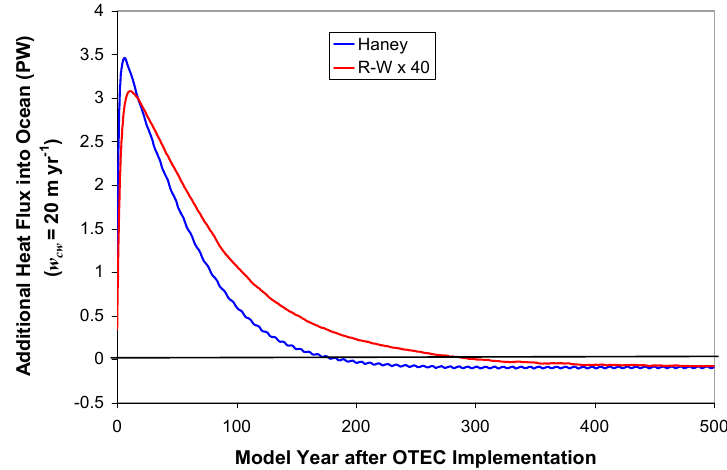
Figure 2. Time history of the additional net heat flux into the ocean when implementing a global Ocean Thermal Energy Conversions (OTEC) scenario ( w cw = 20 m year − 1 ) in MITgcm with different ocean-atmosphere thermal boundary conditions.